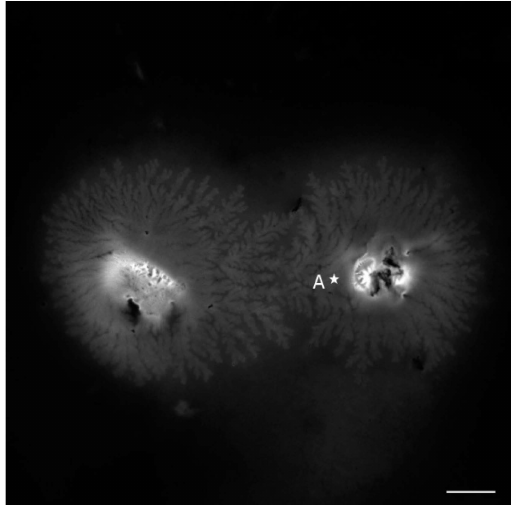
Figure 4. LSCM image of precipitated DNA (evaporated solution No. 3). The 514 nm was used as the pump beam and the fluorescent emission was detected in the (550–650) nm and (650–750) nm ranges. The scale bar donates 40 µ